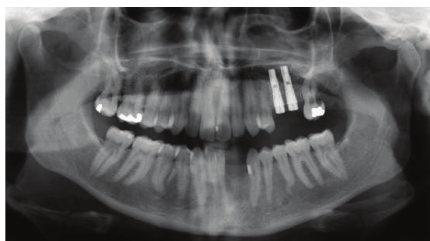
Figure 8: Patient 2: panoramic radiograph from 2004 demon- strating that the left mandibular incisors and left second maxillary premolar and first molar have been extracted. A filling is seen now in the mesial part of the cervical region at the left mandibular canine. Cervical resorption is observed distally in the left maxillary second molar. Implants have been inserted in the left maxillary premolar/molar region.